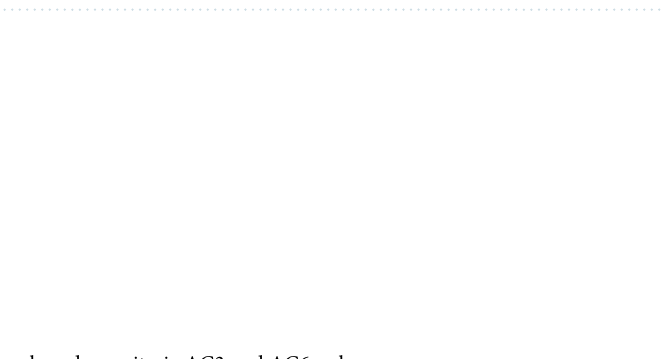
Figure 7. The set of three triangular fuzzy numbers for AC3 and AC6.